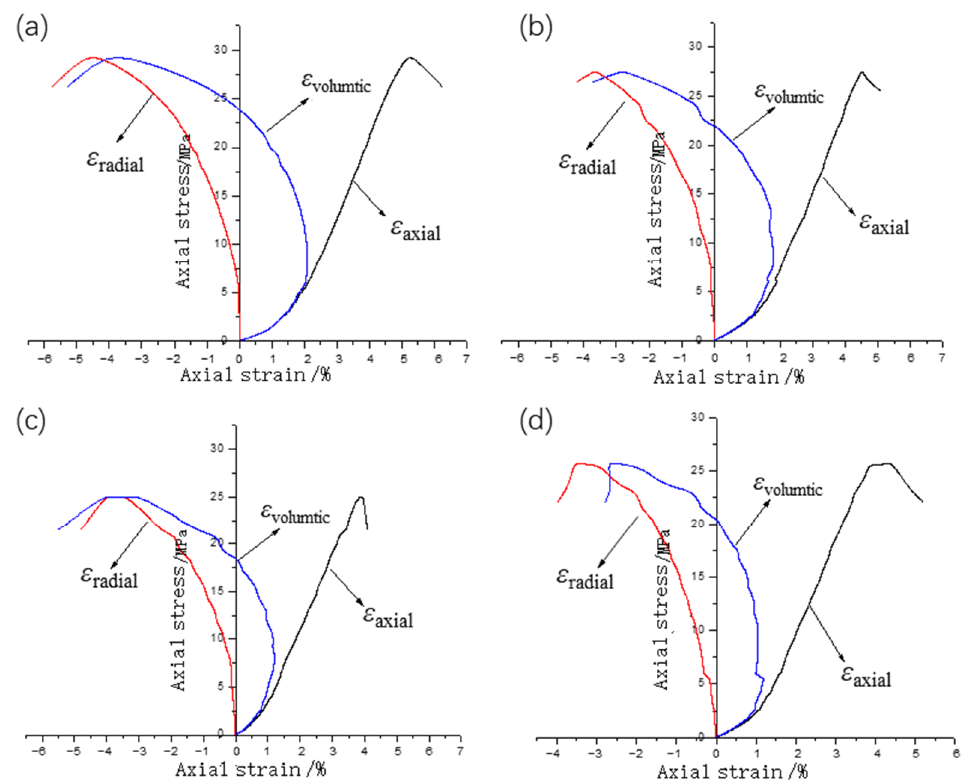
Figure 7. The axial, radial and volumetric strain of coal under compression with different initial gas pressures; ( a ) 0.3 MPa; ( b ) 0.7 MPa; ( c ) 1.1 MPa and ( d ) 1.5 MPa. pressures; ( a ) 0.3 MPa; ( b ) 0.7 MPa; ( c ) 1.1 MPa and ( d ) 1.5